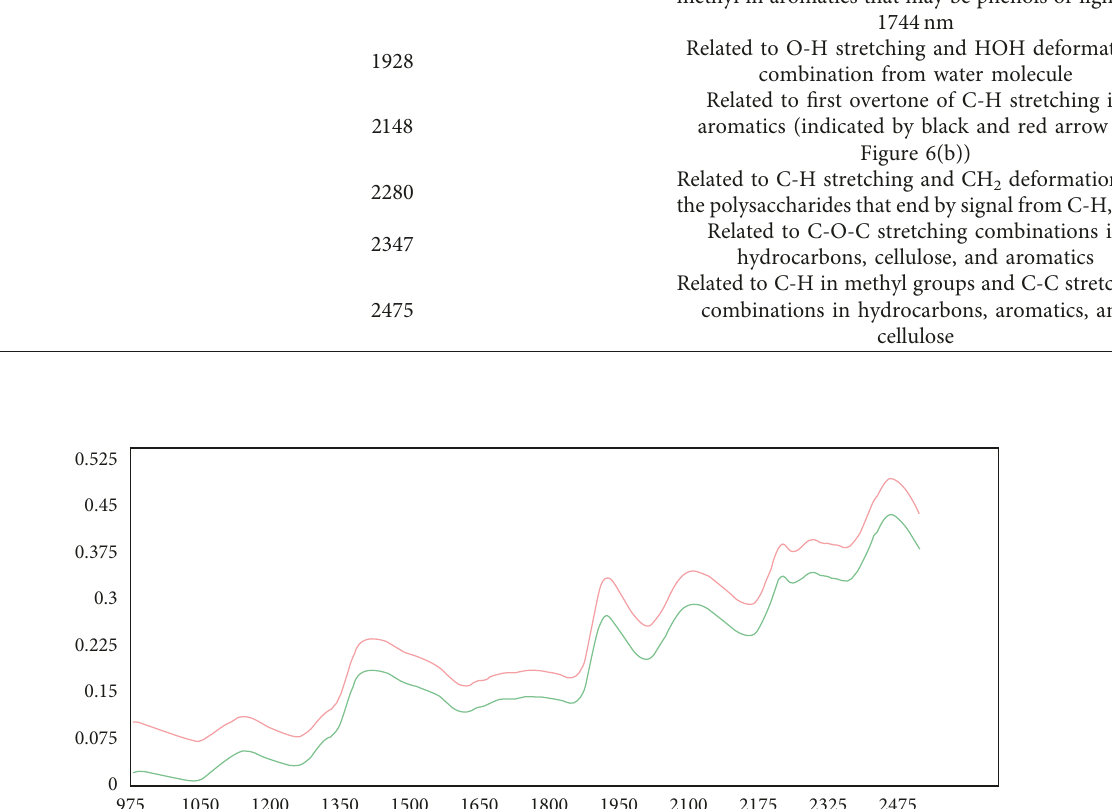
Figure 8: The average spectrum of naturally seasoned and kiln-dried wood surfaces (red line) and the average spectrum of surfaces contaminated by fungi (green line).